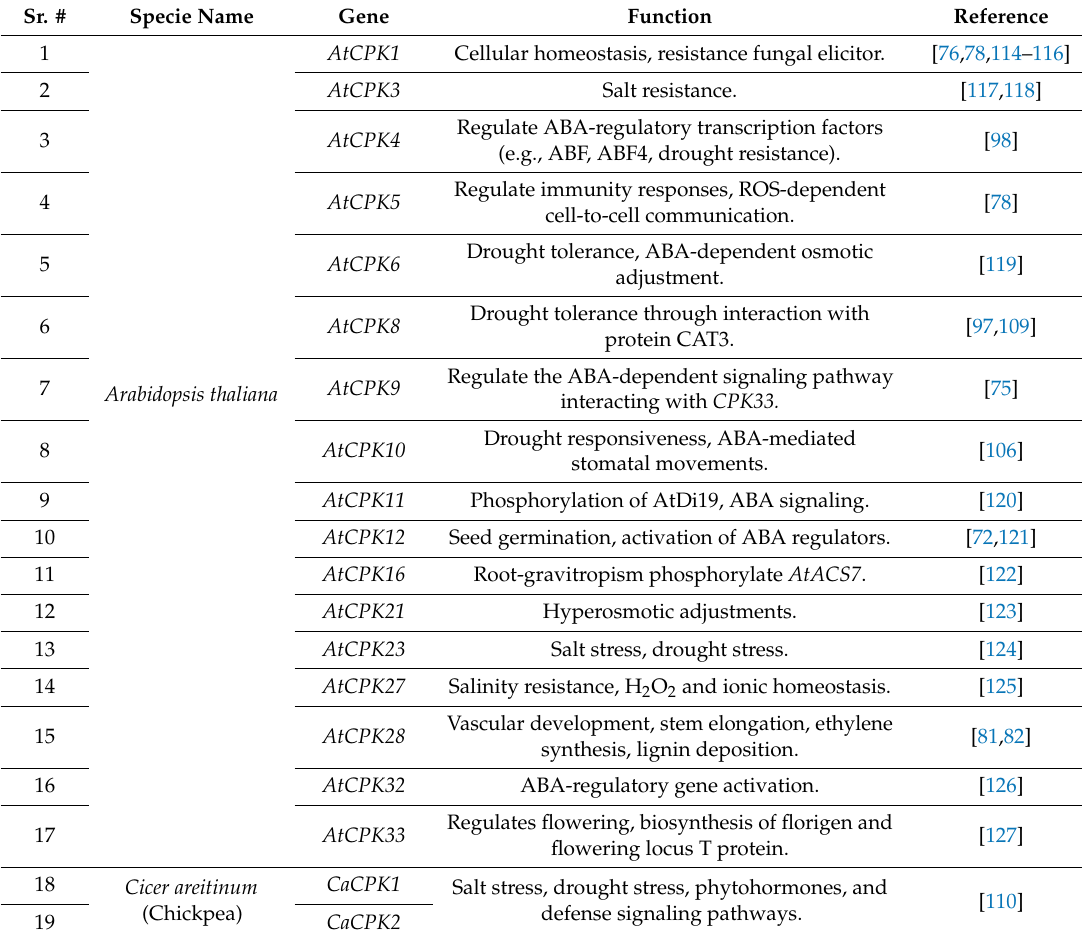
Table 2. Various functions of CPKs in biotic and abiotic stresses in di ff erent plant species. Sr.